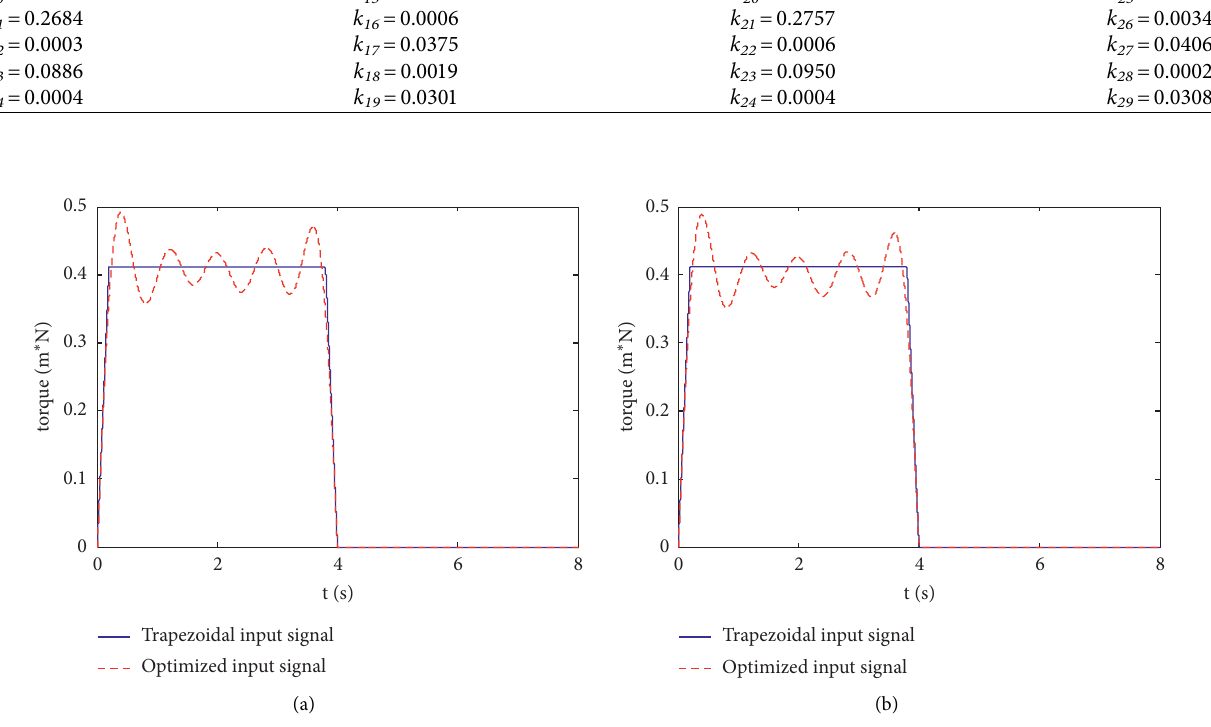
Figure 12: Comparison of the input signal: (a) Joint 1 input signal; (b) Joint 2 input signal.